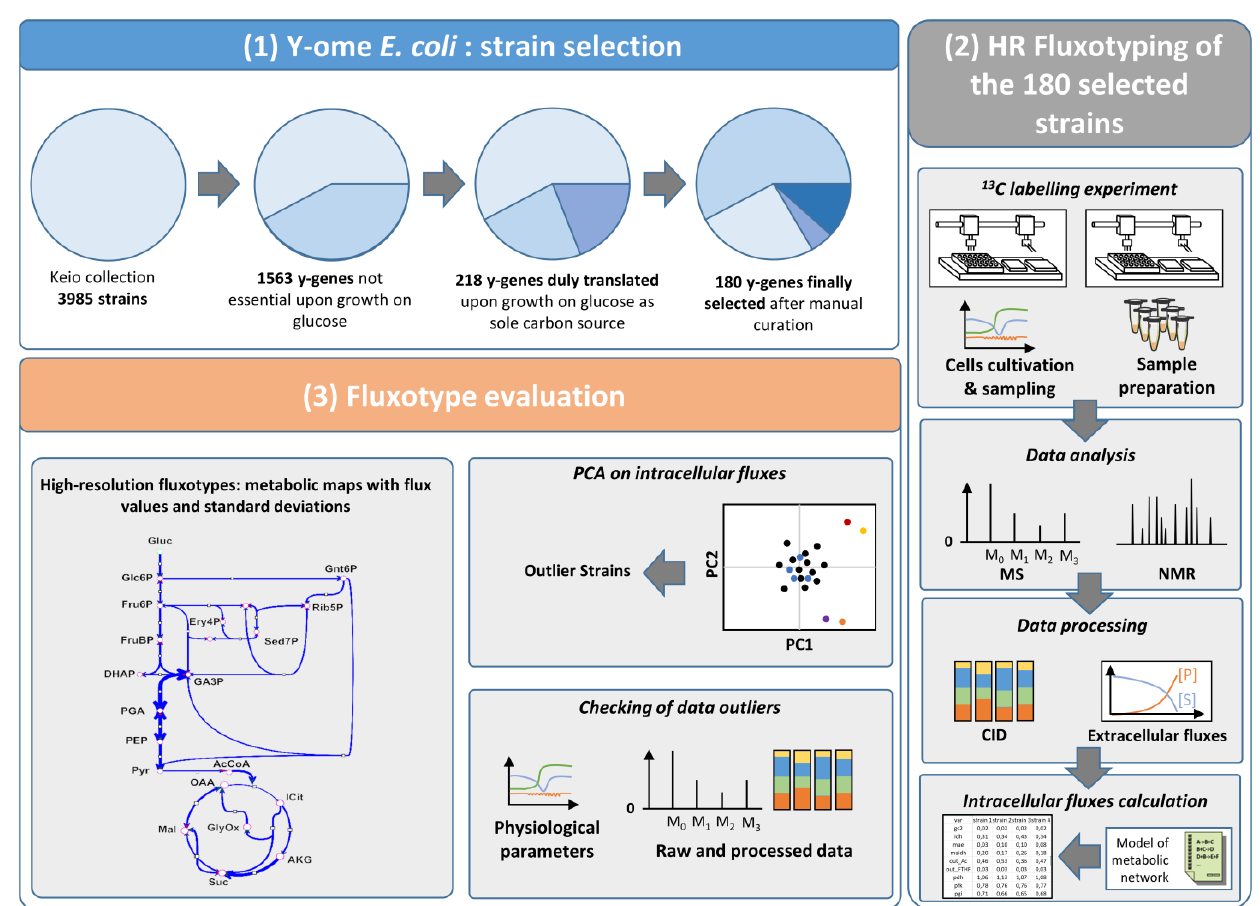
Figure 1. Strategy for high-resolution fluxotyping of the E. coli y-ome. Selection of E. coli y-genes ( 1 ) 180 y-genes were selected based on their expression on glucose as sole carbon source. High-resolution Fluxotyping ( 2 ) of 180 mutants with single-deletion of a selected y-gene. Cell cultivation, metabolite harvesting and sample preparation are performed by robotic systems. Quantification of medium compounds and isotopic profiling of metabolites by NMR and MS. Fluxes are calculated using a model of E. coli central carbon metabolism. Fluxotype evaluation ( 3 ) Metabolic fluxes are calculated for all strains (high-resolution fluxotypes) and compared by statistical analysis to identify altered fluxotypes. Fluxotype outliers are checked against culture data to ascertain that outlying flux values are not due to a 13 C-labelling problem. Metabolites: Gluc.: Glucose, Glc6P: glucose-6-phopshate, Fru6P: fructose-6-phosphate, FruBP: fructose-bisphophate, DHAP: